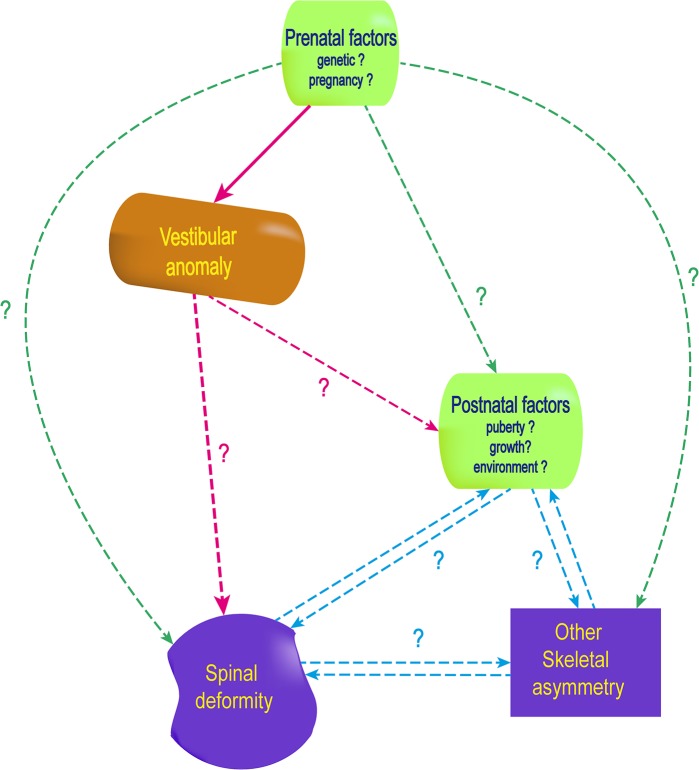
Early anomalies of the vestibular system in AIS pathogenesis and consequences in adolescent idiopathic scolisosis pathogenesis.The pink dash arrows represent the hypothesis that a vestibular anomaly may be the cause of later anomalies, including spinal deformity. Different mechanisms supporting this hypothesis are illustrated in Fig 6.